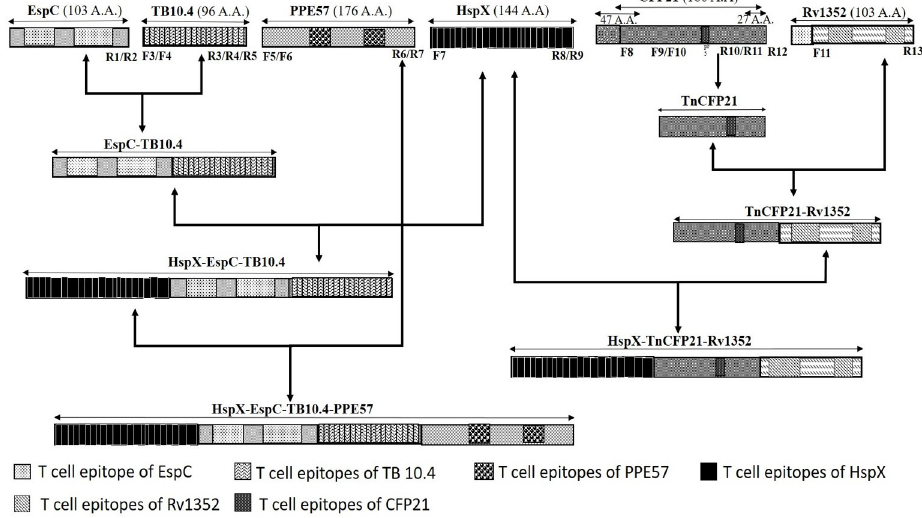
Fig 1. T-cell specific epitopes of the antigens used in this study as the scheme for construction of the fusion molecules.